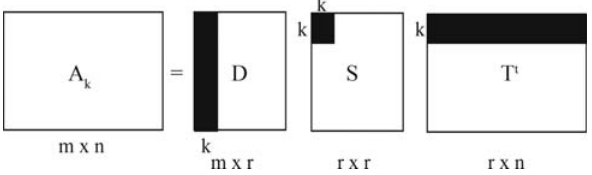
Figure 3 - Mathematical representation of the matrix A k . This matrix is an approximation of the original document by term matrix using the k largest singular values and their corresponding singular vectors. A is the matrix of document by terms, or proteins by theirs contact vectors; D has orthogo- nal, unit-length columns ( D t D = I n ); T has orthogonal, unit-length columns ( T t T = I n ); m is the number of rows of A , or the numbers of proteins; n is the number of columns of A ; n is the number of columns of A , or the length of the contact vector; r is the rank of A m m (cid:6) min(m, n) ; k is the chosen num- ber of dimensions in the reduced model ( k (cid:6) r